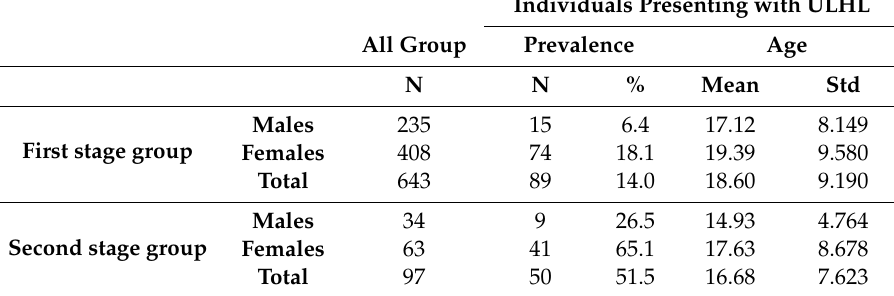
Table 1. Descriptive analysis of the study samples: the survey group (First stage) and the analyzed group (Second stage).